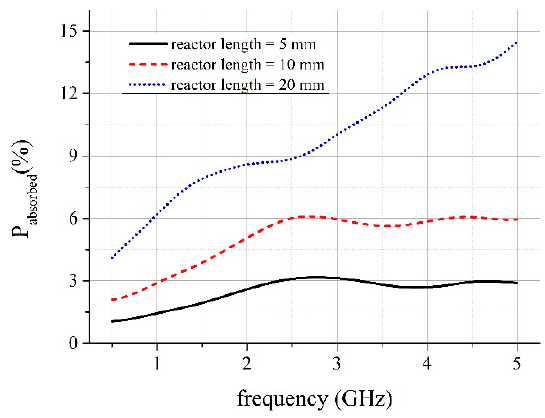
Figure 4. Expected power absorption in the reactor.